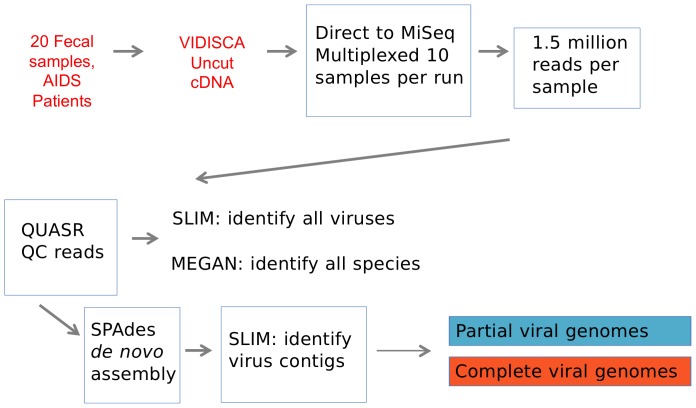
An overview of the ViSeq process.